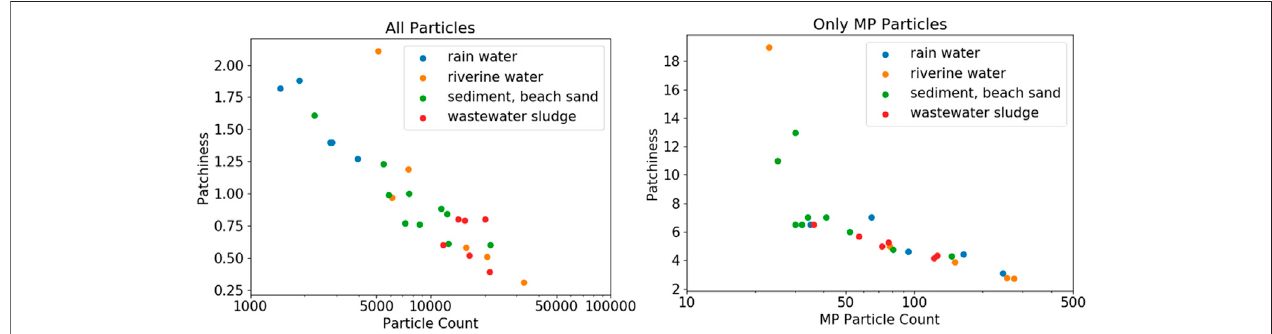
FIGURE 8 | Particle patchiness as a function of total particle count and MP particle count, respectively. Note the logarithmic scale of the particle count. The patchiness is generally lower at higher particle counts.